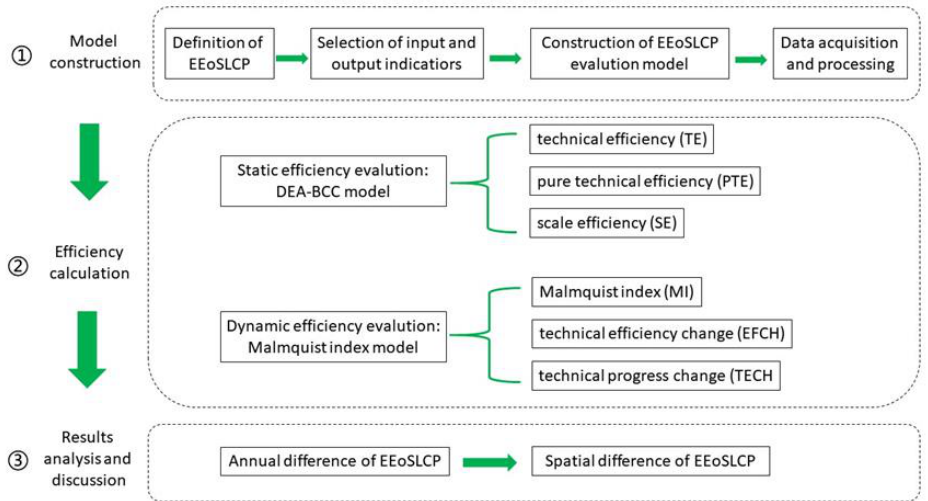
Figure 2. The analytical framework and the methodology used in this study.